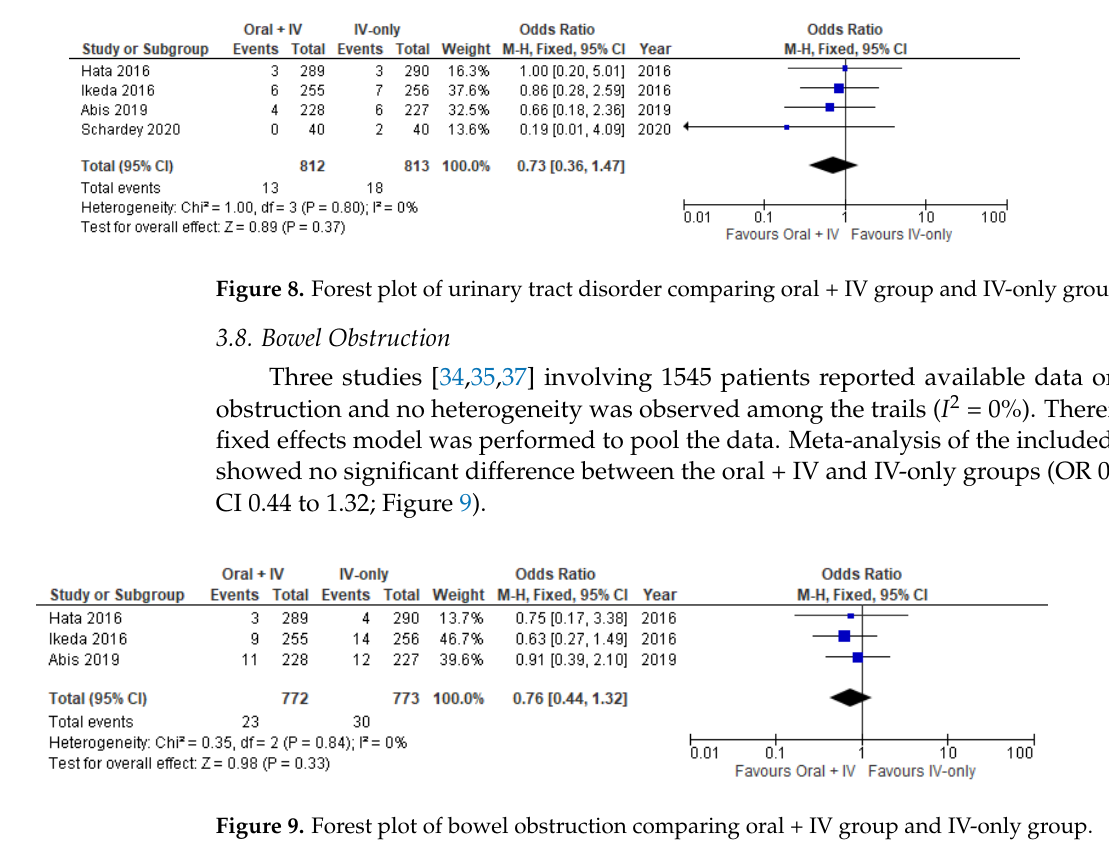
Table 2. Summary of Findings (SoF) table.